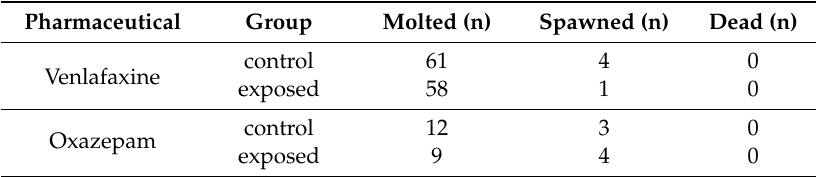
Table 7. The total number of molted, spawned, and dead crayfish in the control and exposed groups during the exposure period to venlafaxine and